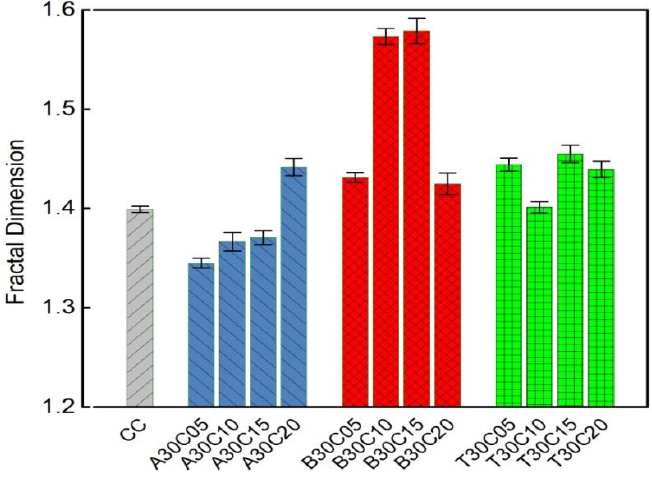
Figure 3. Failure characteristics of the samples.